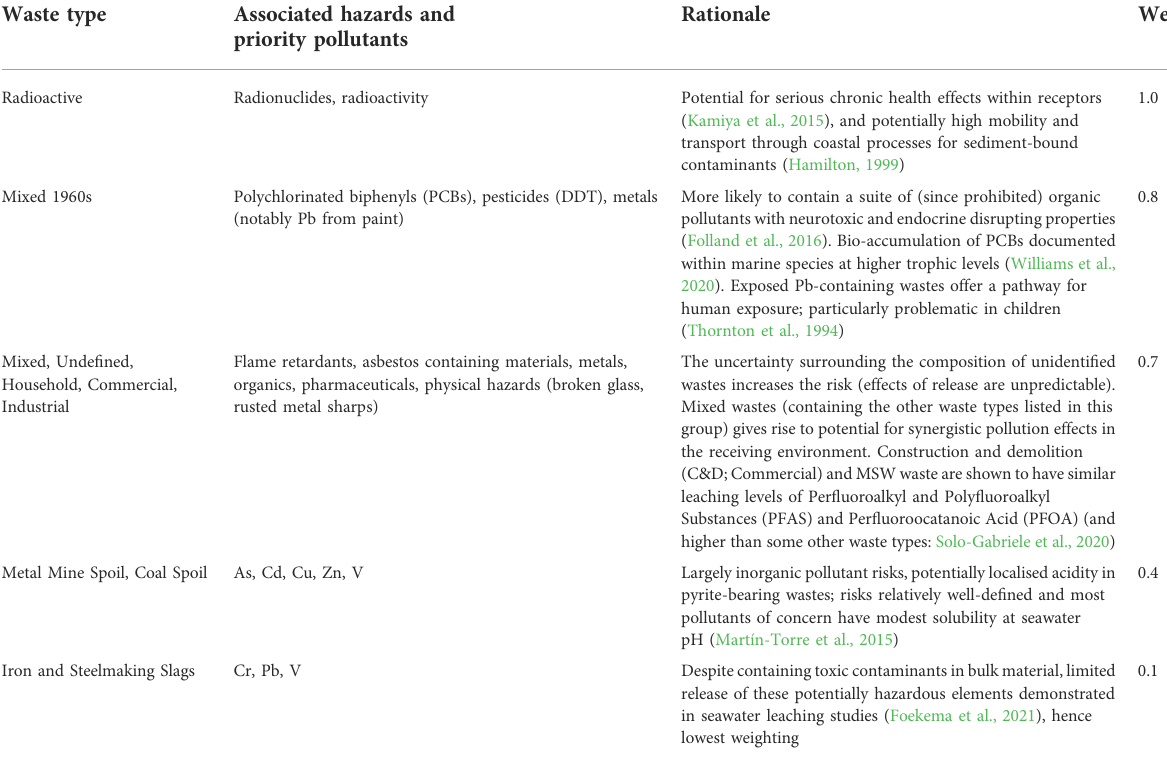
TABLE 1 Waste categories with details of key probable pollutants, references, and